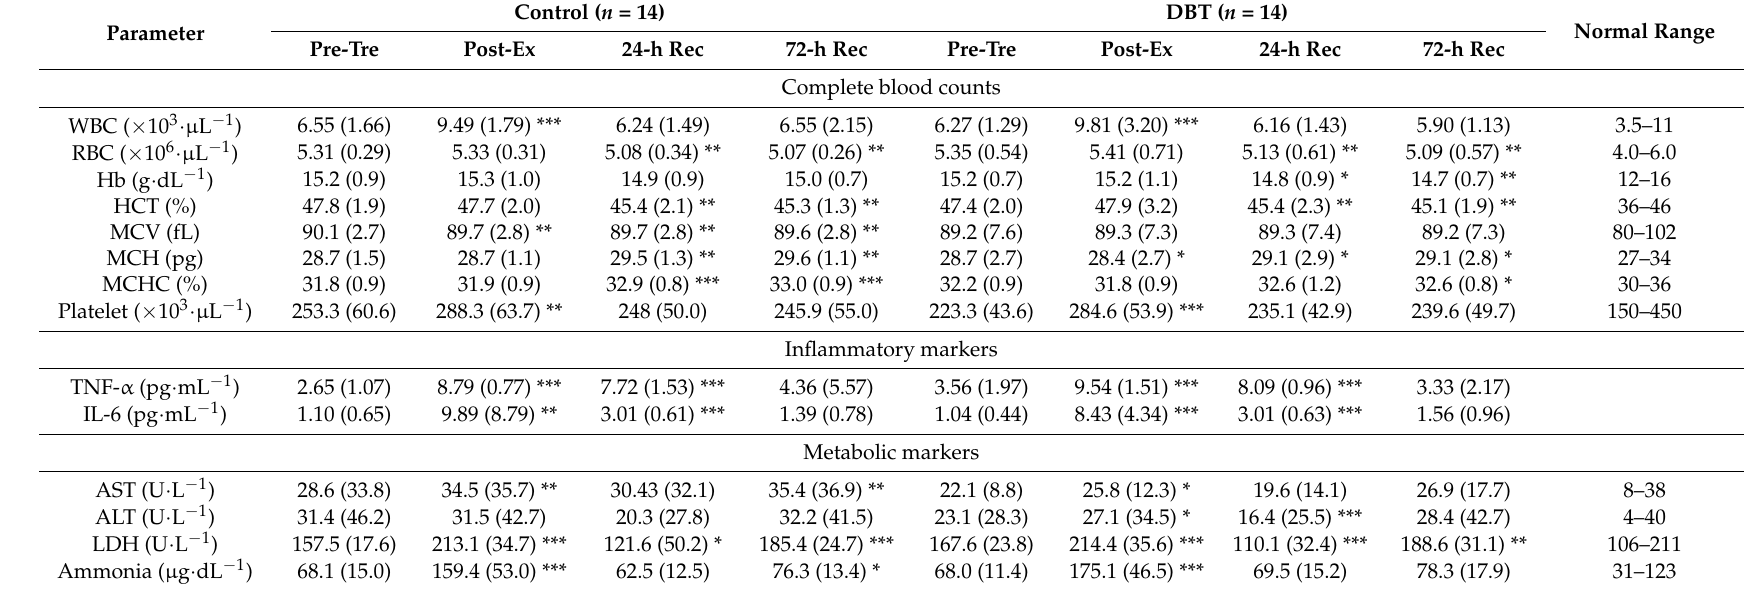
Table 4. Complete blood counts and concentrations of inflammatory and metabolic